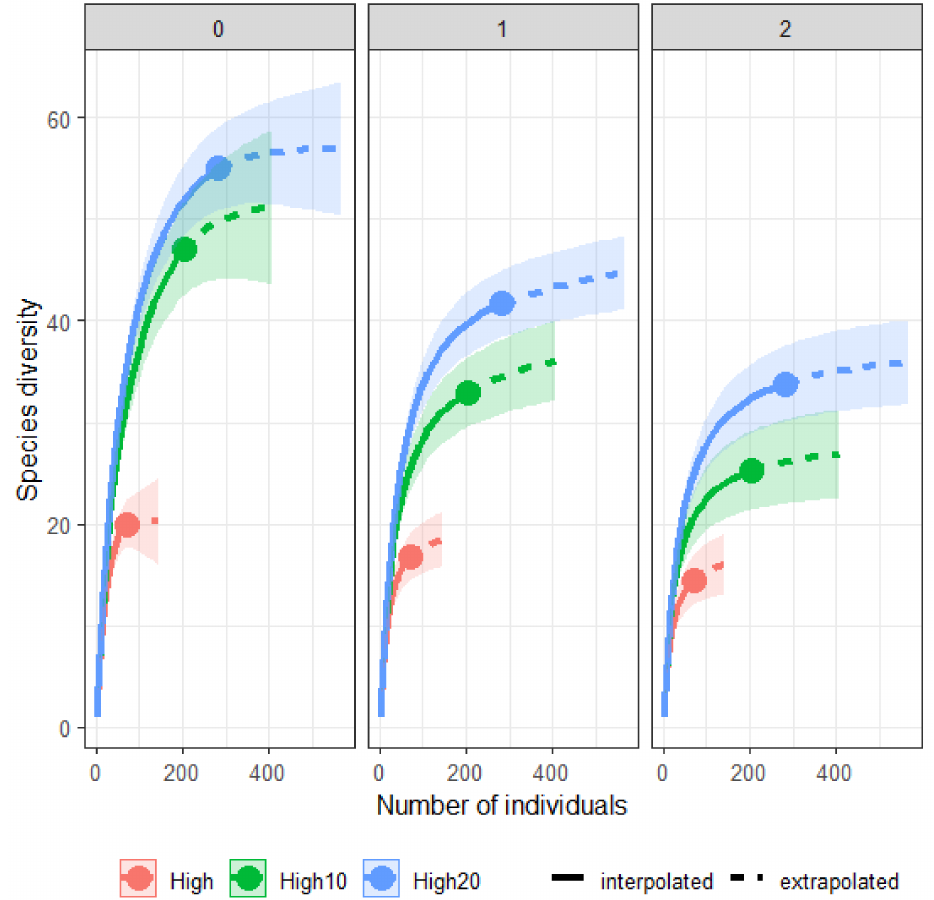
Figure 6. Comparison of tree species biodiversity between different sites under high utilization management regimes based on Hill numbers for different orders (0, 1, and 2). The solid and dotted lines represent the rarefaction and extrapolation curves, respectively. The shaded area indicates the confidence interval at 95%, based on bootstrap method with 200